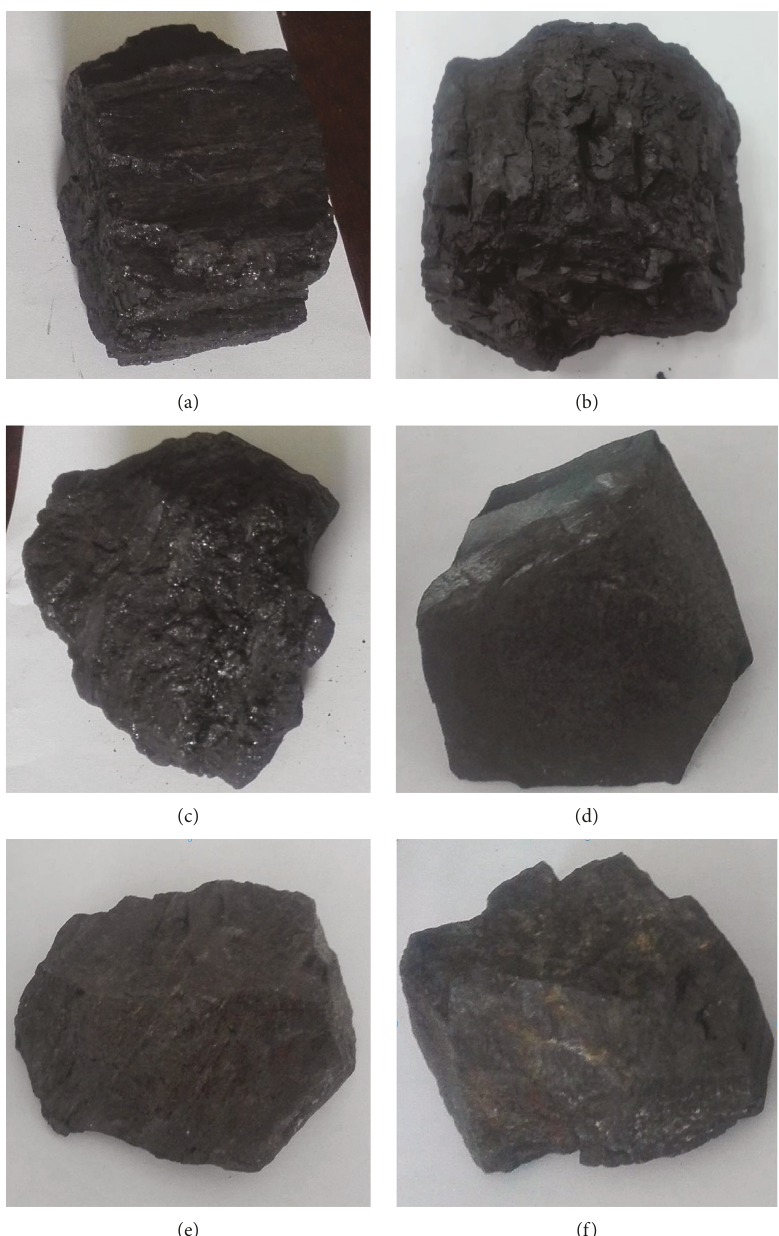
Figure 1: Six typical bituminite (a–c) and carbonaceous shale (d–f) samples of